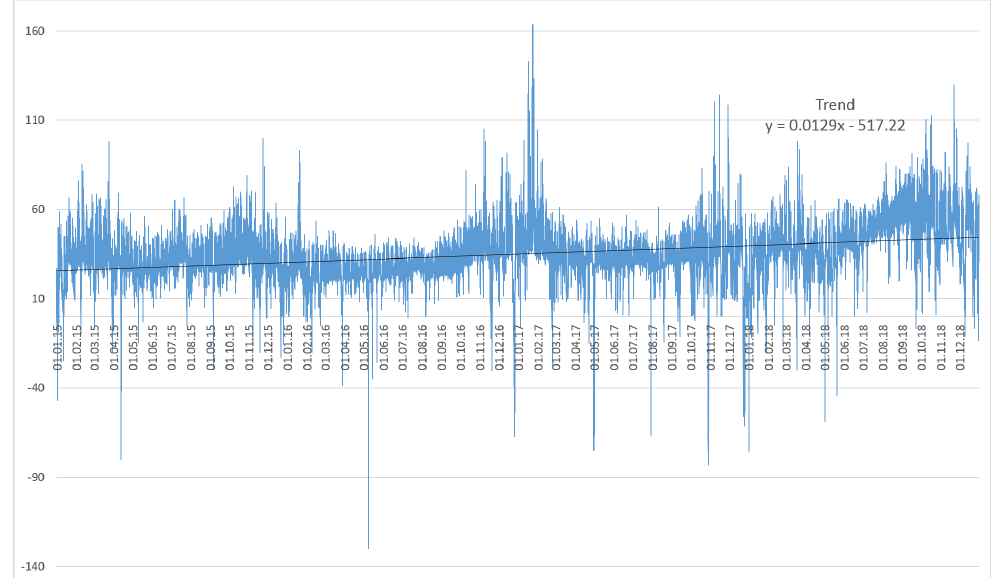
Figure 3. Hourly development of the wholesale spot market electricity price, 1 January 2015–31 December 2018 with a linear trend. Source: [19].